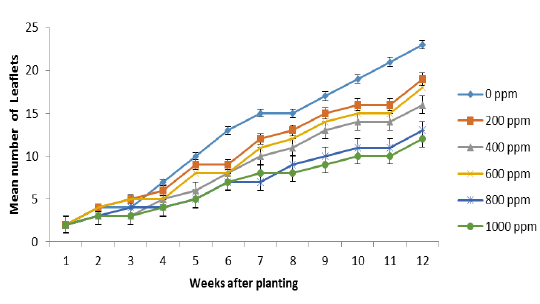
Fig. 2. Effect of different treatments of lead on the number of leaflets of Pteris vittata